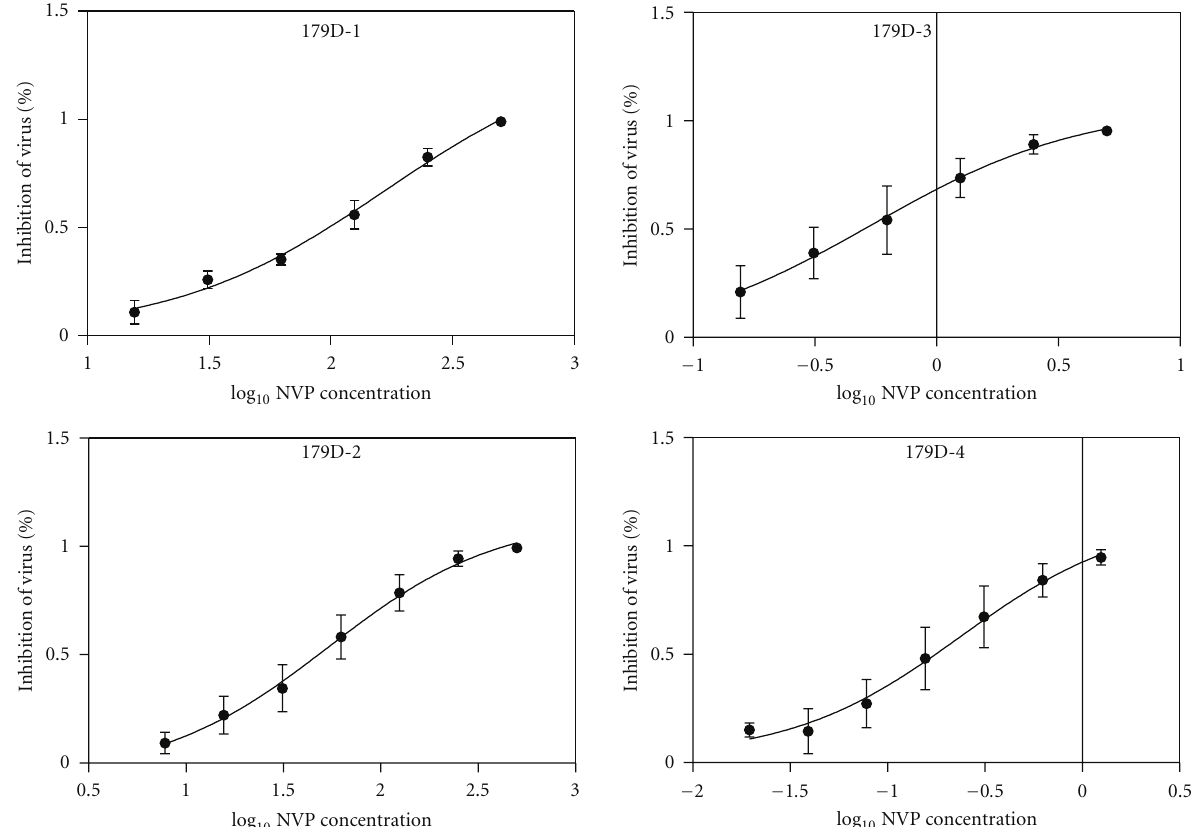
Figure 2: The curves of percent inhibition of virus 179D-1 ∼ 179D-4 to log 10 NVP concentration.